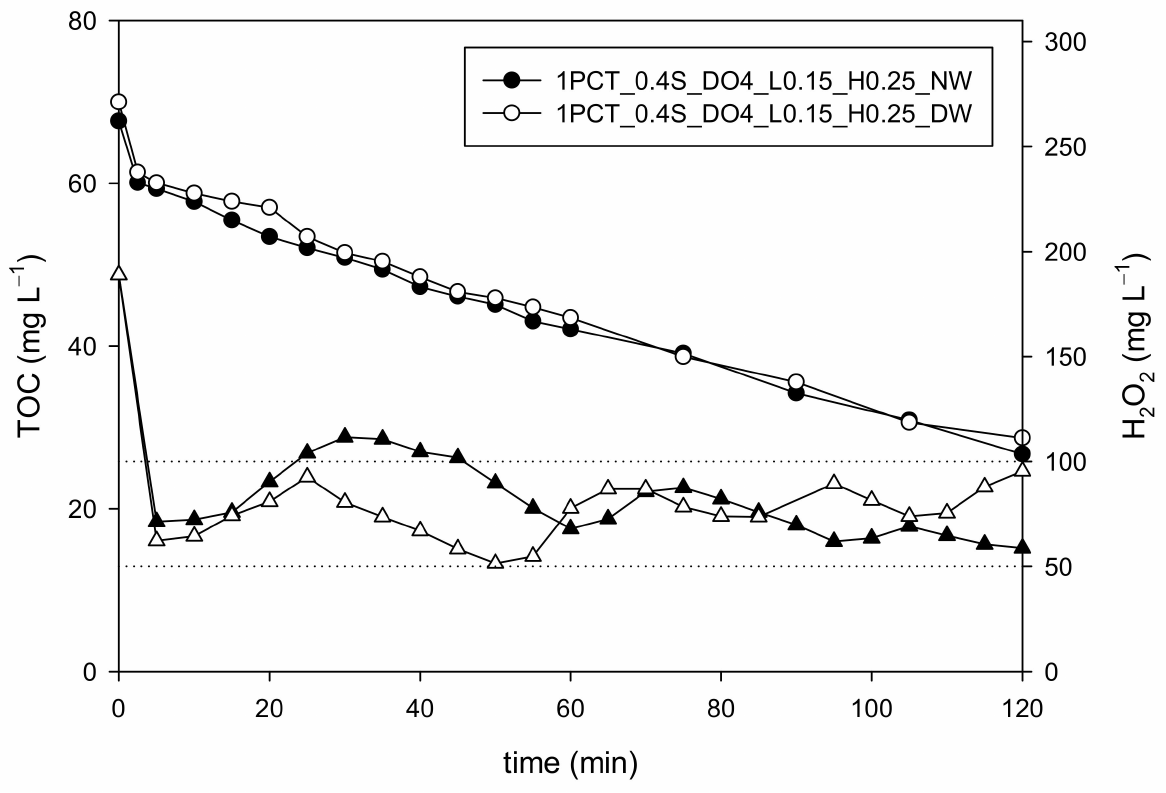
Figure 2. Comparison of TOC (round symbols) and H 2 O 2 (triangular symbols) concentration profiles when the 0.4S_DO4_L0.15_H0.25 dosage strategy is applied for the treatment of 100 mg L − 1 PCT (63 mg L − 1 TOC) contaminated wastewater in NW and DW by photo-Fenton